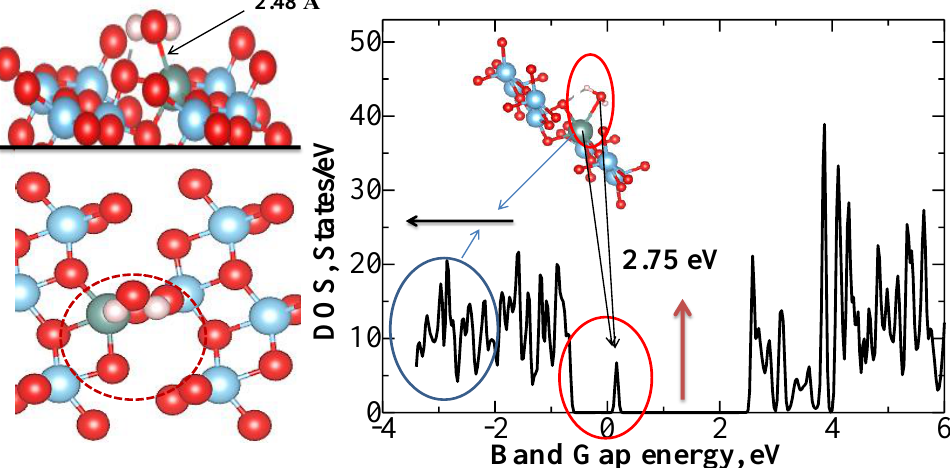
Figure 4. Structural images of the upper layer and DOS of the TiO 2 system during adsorption of H 2 O - molecules parallel to the Y axis